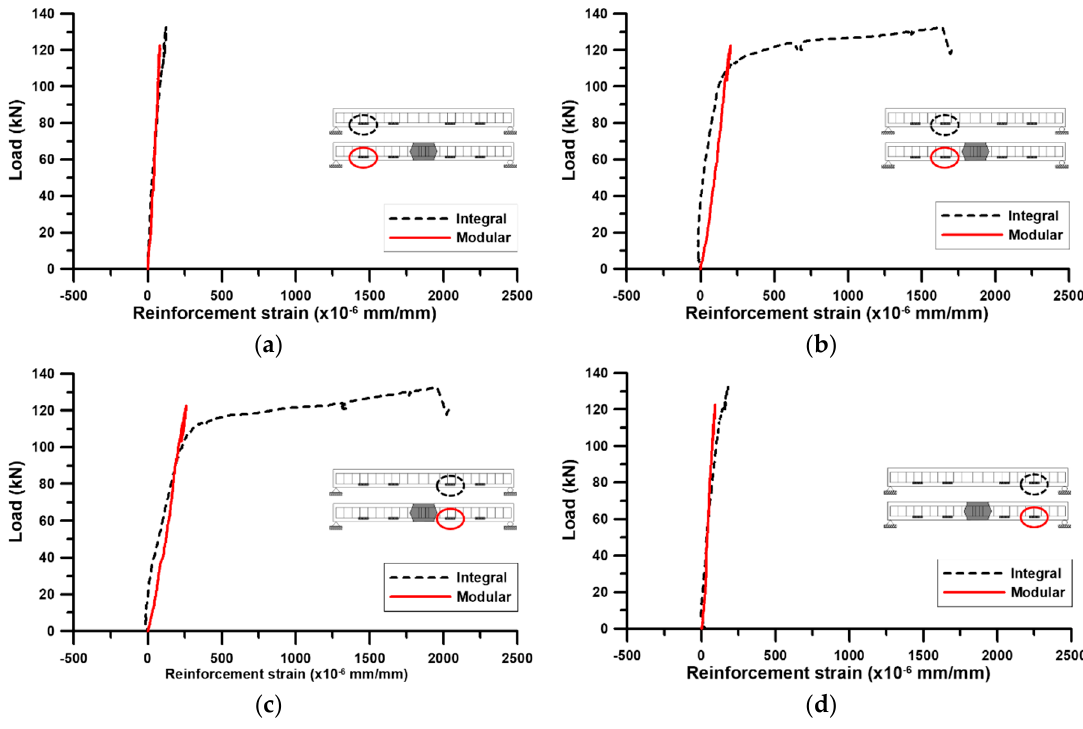
Table 3. Measured strain at location S1, S2, S3, and S4 of integral and modular specimen